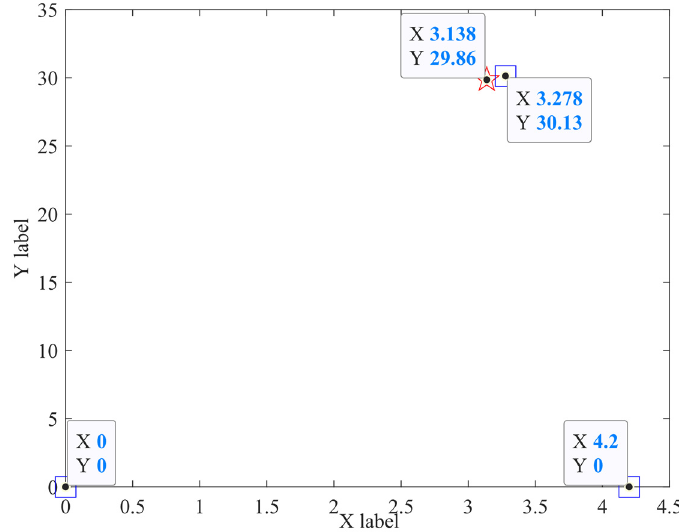
Figure 13. Actual and tested position map of the target (Unit: m).